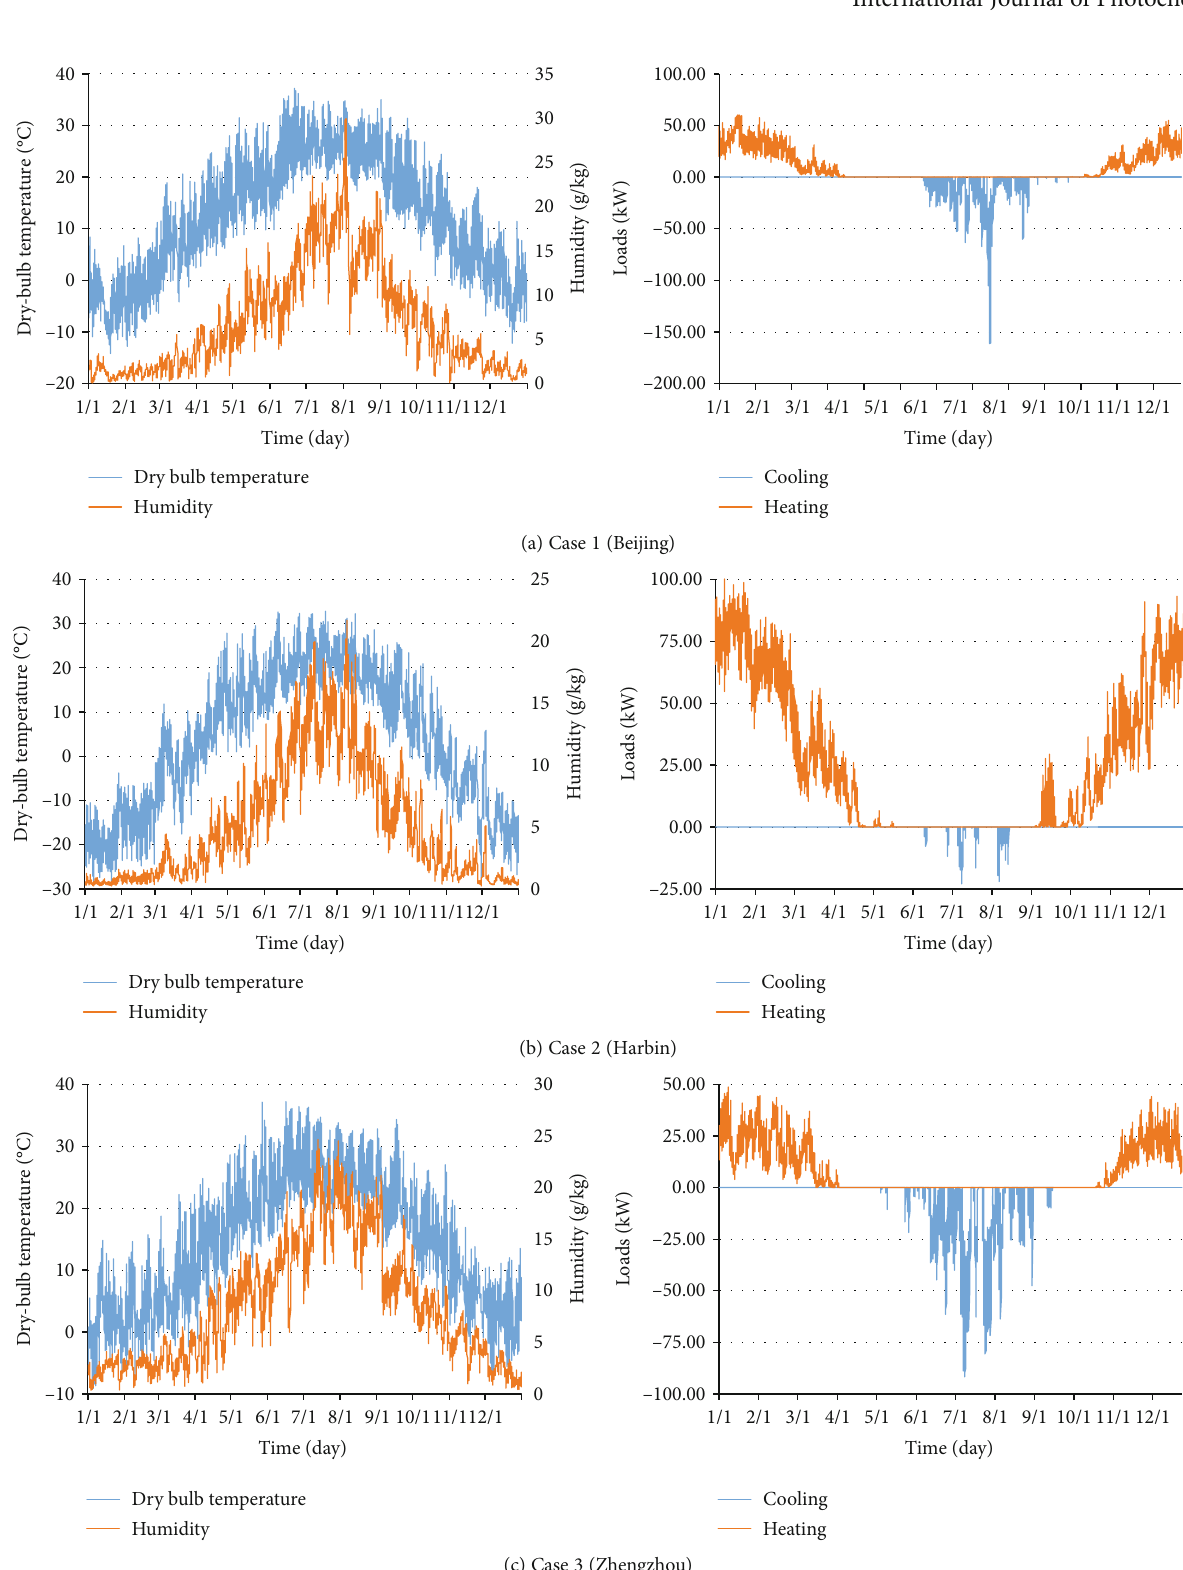
Figure 7: Climate characteristics and dynamic building loads for di ff erent uses in the Beijing, Harbin, and Zhengzhou